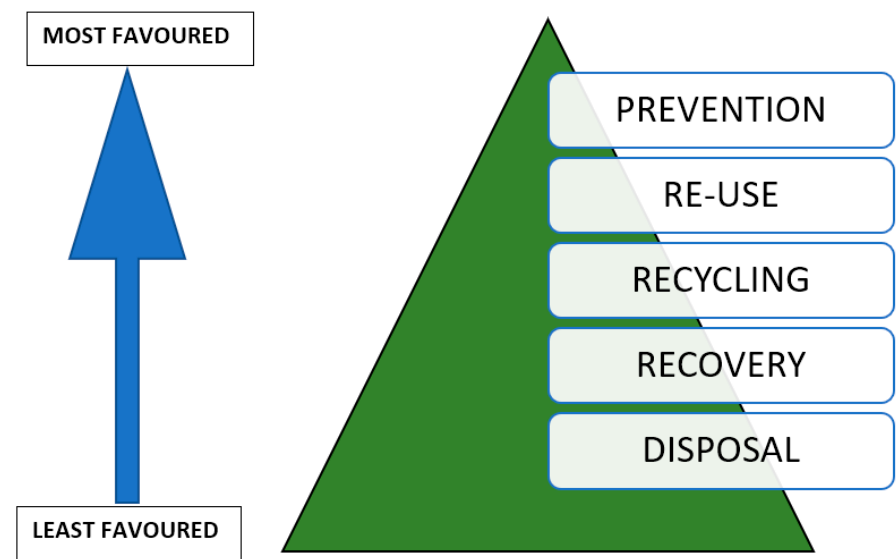
Figure 1. EU Waste Management Hierarchy. Adapted from [18].